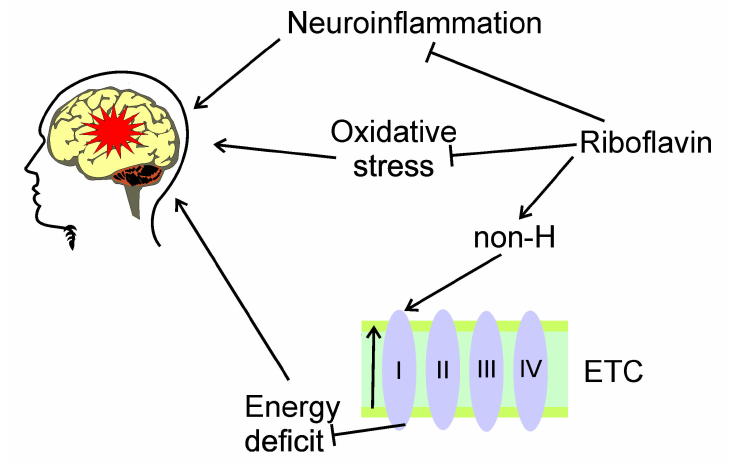
Figure 3. Potential beneficial effects of riboflavin in migraine. Riboflavin may exert protective effects in migraine, symbolized here by a red star, by the modulation of the mitochondria-energy production-oxidative stress pathway, but its details are poorly known. Riboflavin may reduce oxidative stress associated with migraine. Riboflavin targets complex I of the electron transport chain (ETC, simplified here to complexes I–IV), whose activity may decrease in migraineurs, especially those with non-H mitochondrial haplotype (non-H). Riboflavin may ameliorate energy deficit resulted from malfunction of the complex I, and, in this way, decreases migraine-related symptoms. These activities result from the involvement of riboflavin in mitochondrial homeostasis. Riboflavin may also reduce neuroinflammation, important in migraine